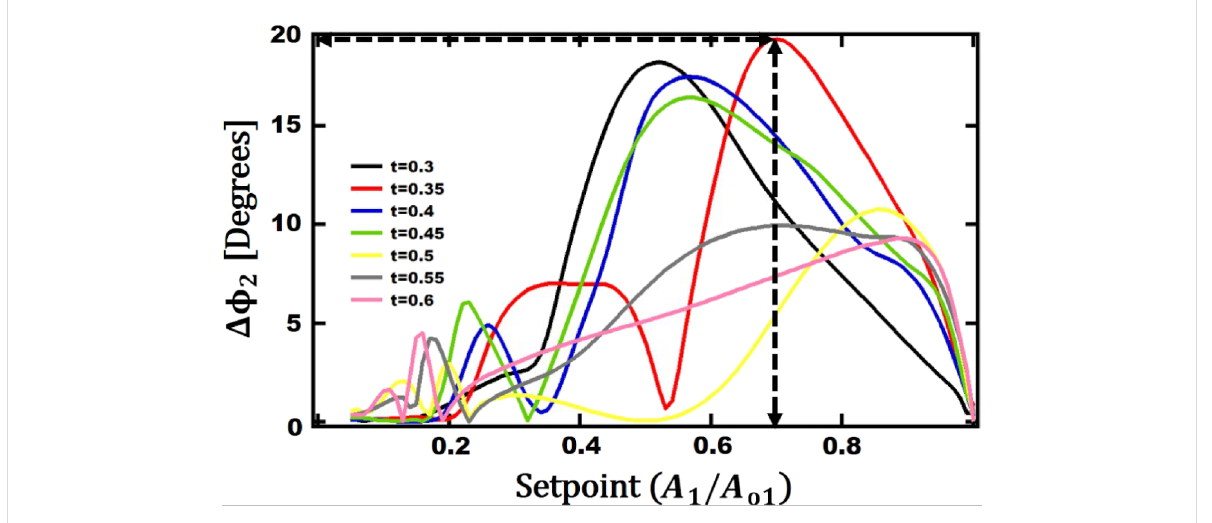
Figure 10: Second eigenmode phase difference between Au and PS as function of the setpoint for different cantilever thickness values. The other geometrical parameters are: L opt = 90 µm, b opt = 254 µm, and = 32 µm.